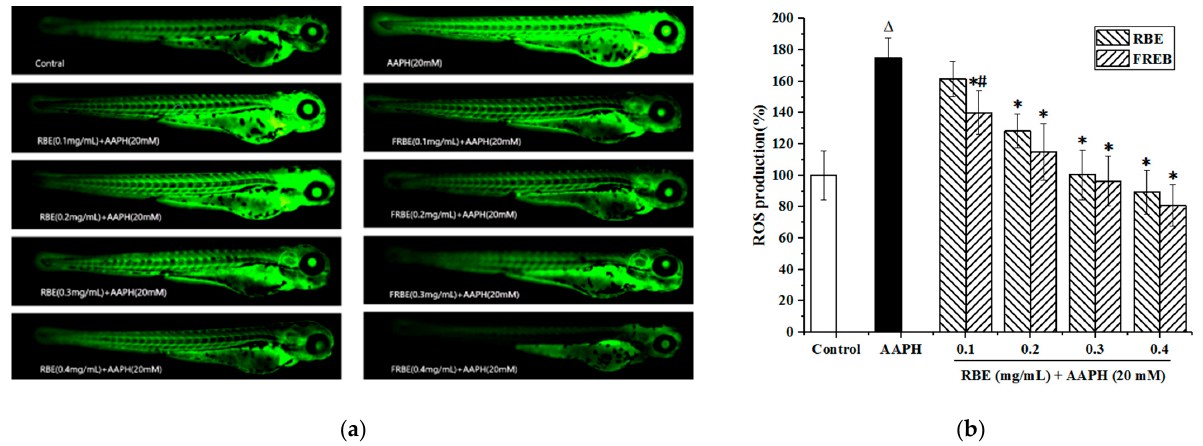
Figure 2. Protective effects of RBE and FRBE on AAPH-treated ROS production in zebrafish. ( a ) levels were measured by image analysis and fluorescence microscopy; ( b ) ROS levels were measured using Image J software. Experiments were performed in triplicate, and the data are expressed as the means ± SE; ∆ p < 0.05 compared to the control group; * p < 0.05 compared to the AAPH-treated group; # p < 0.05 for the comparison between RBE and FRBE.